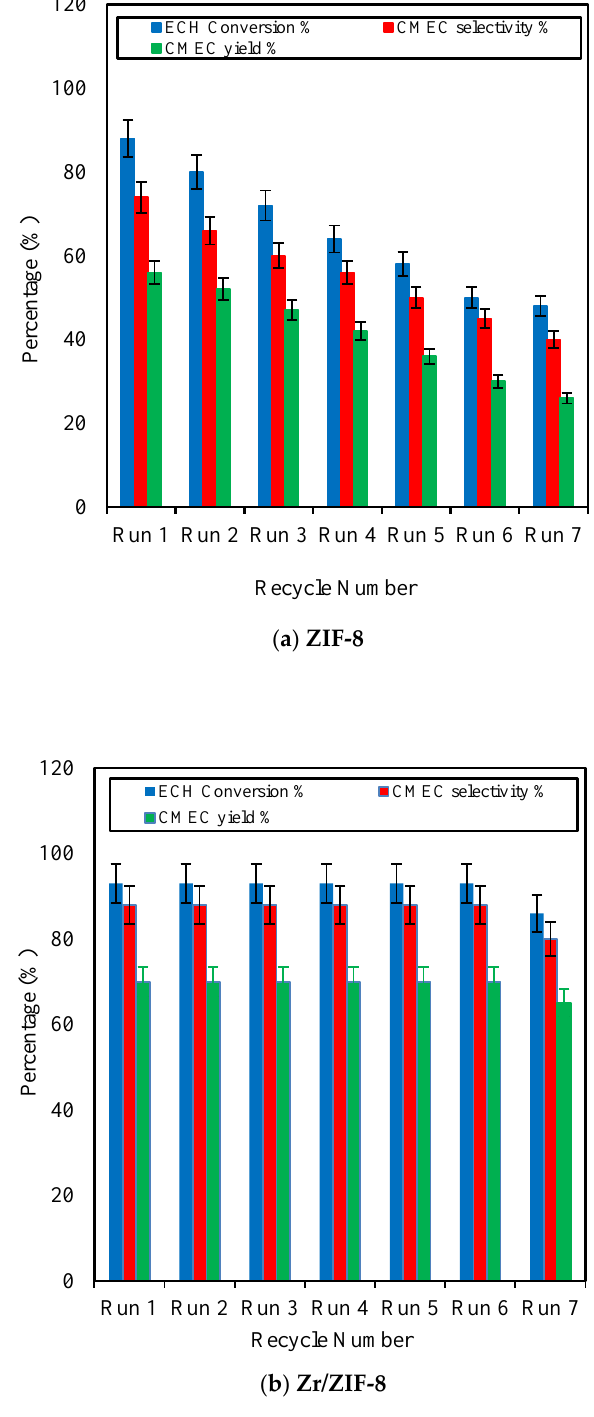
Figure 17. Catalyst reusability studies on conversion of ECH, selectivity and yield of CMEC. Experimental conditions: catalyst: ( a ) ZIF-8 and ( b ) Zr / ZIF-8; catalyst loading 10% ( w / w ); temperature 353 K; CO 2 pressure 8 bar; reaction time 8 h; stirring speed 350